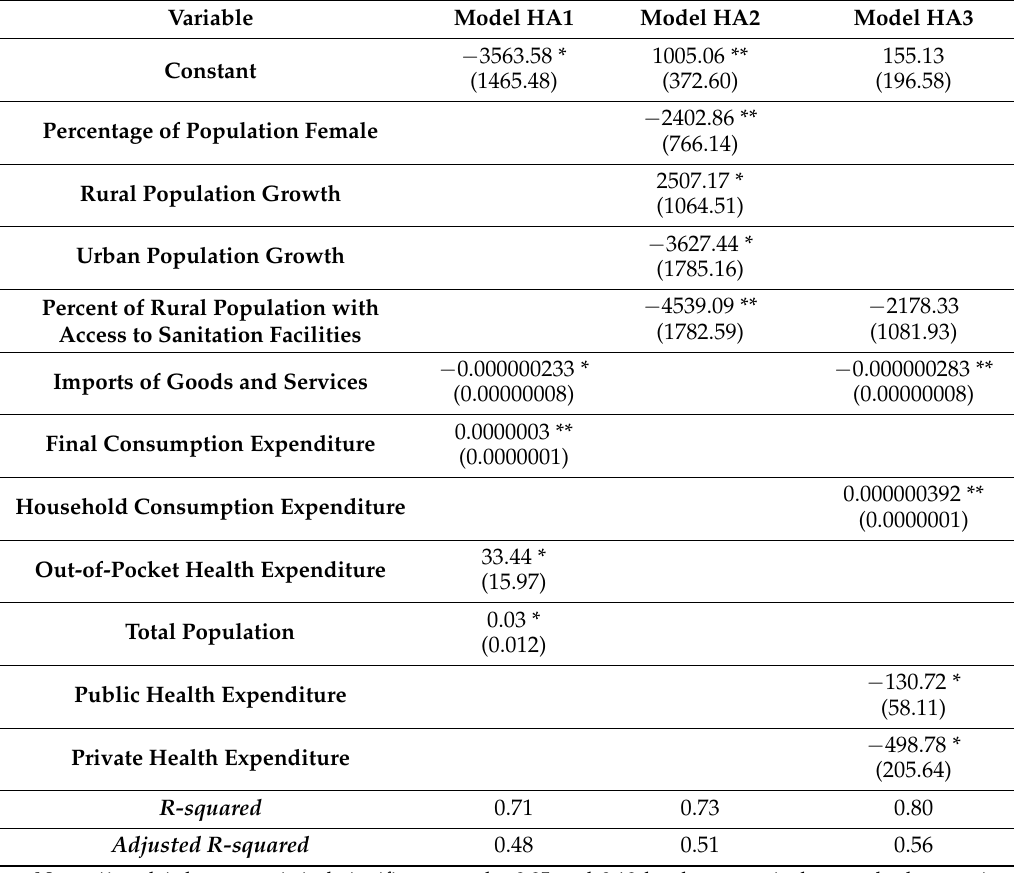
Table 3. Factors influencing the number of cases of hepatitis A in Jordan (years